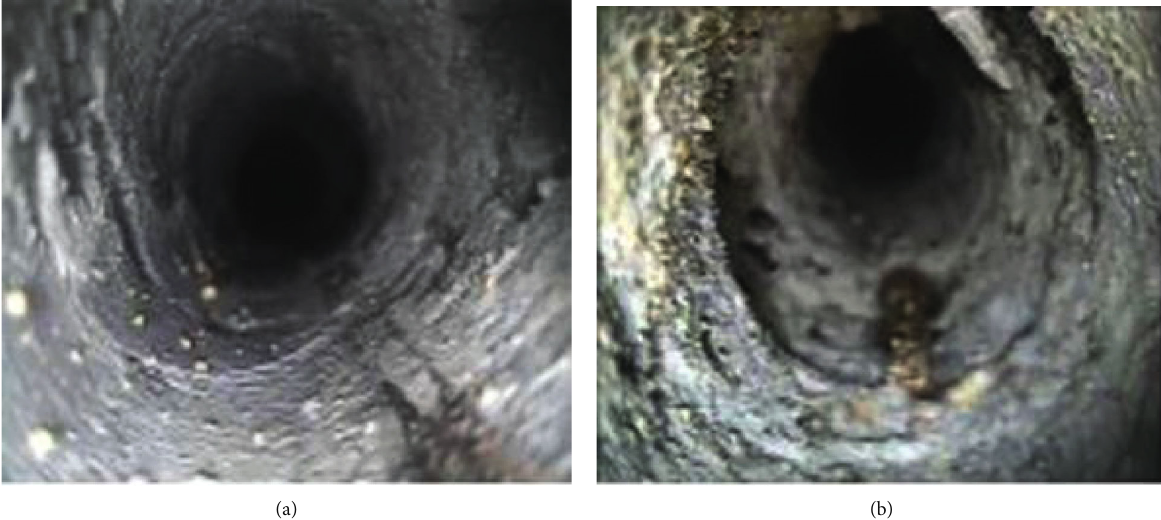
Figure 16: Roof borehole peep view: (a) 1.6m; (b)